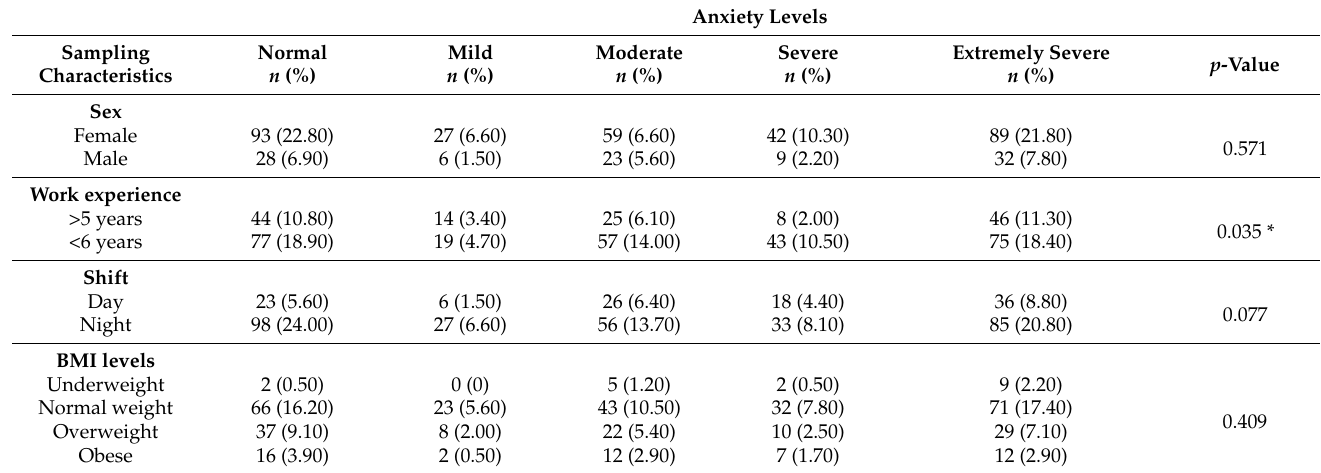
Table 1. Sampling characteristics according to anxiety levels.